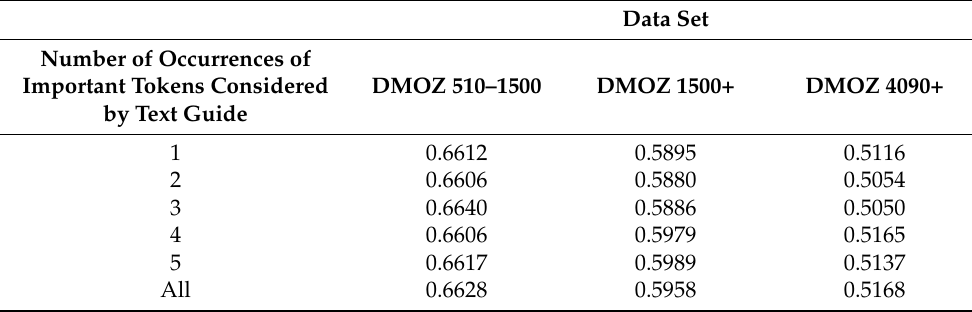
Table 4. Results obtained with a pre-trained AlBERT model and Text Guide in experiments consider- ing various numbers of important token occurrences.